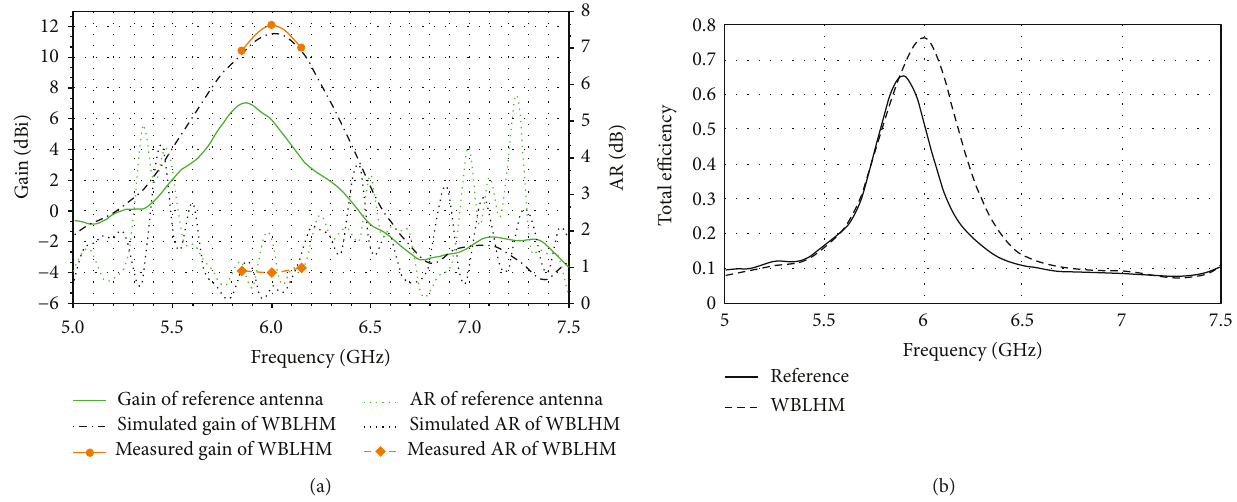
Figure 8: (a) Gain and AR of reference antenna and WBLHM antenna at d =29mm. (b) Total e ffi ciency of reference and WBLHM